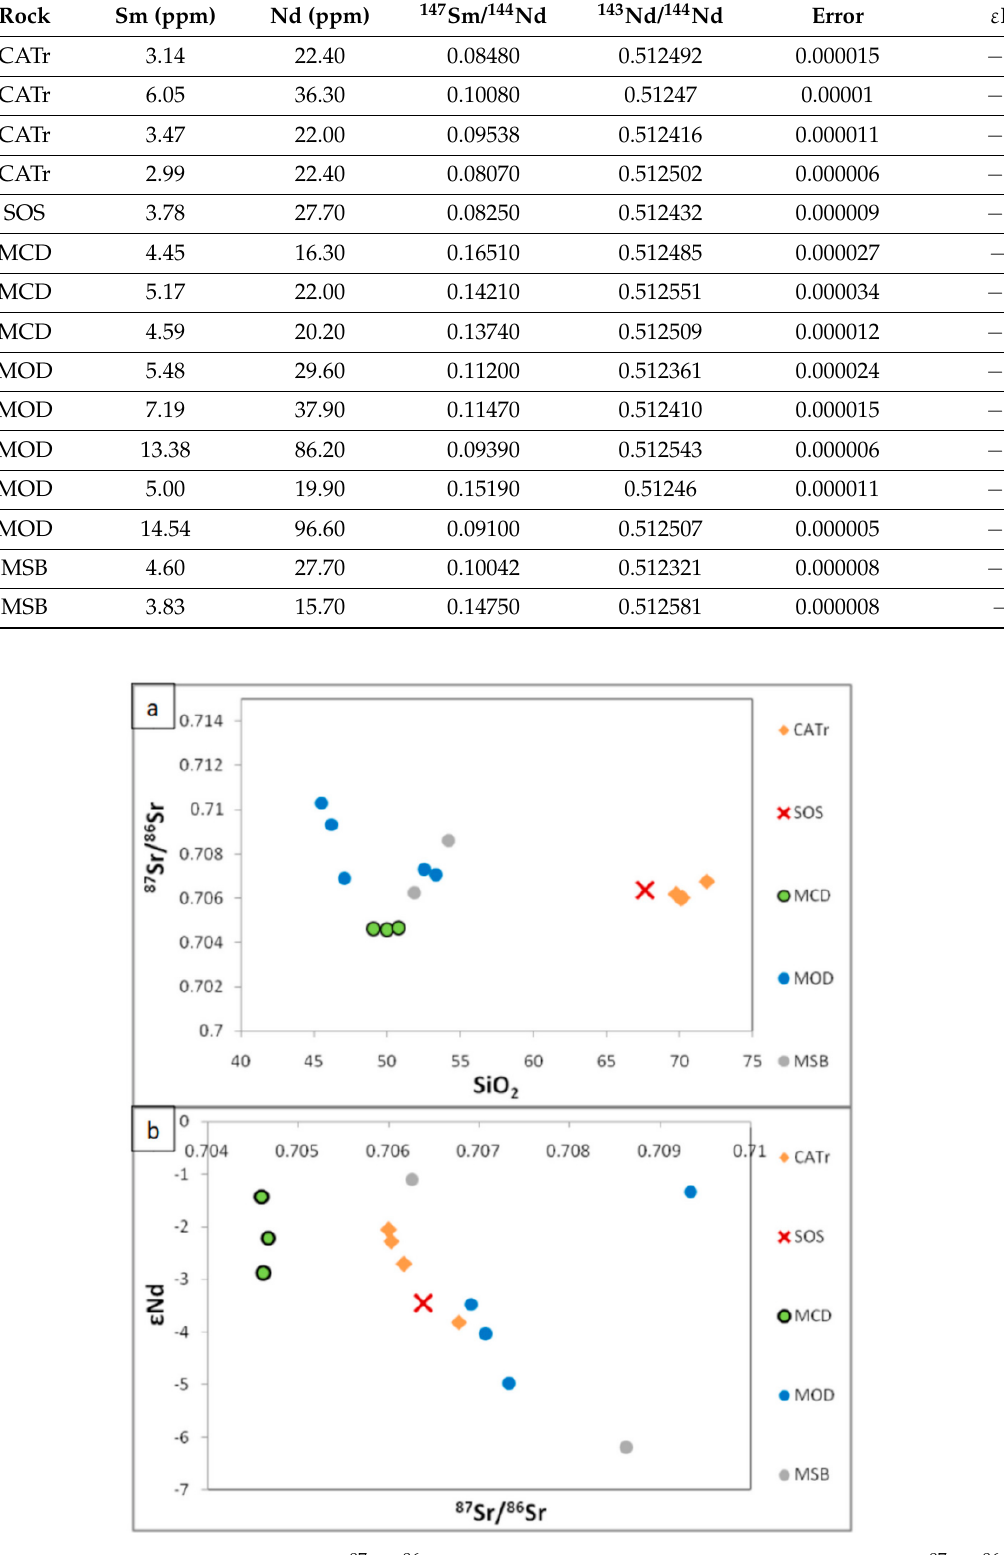
Figure 11. ( a ) SiO 2 vs. 87 Sr/ 86 Sr diagram for Corno Alto–M. Ospedale rocks. ( b ) 87 Sr/ 86 Sr vs. ε Nd diagram for Corno Alto–M. Ospedale samples. Symbols as in Figure